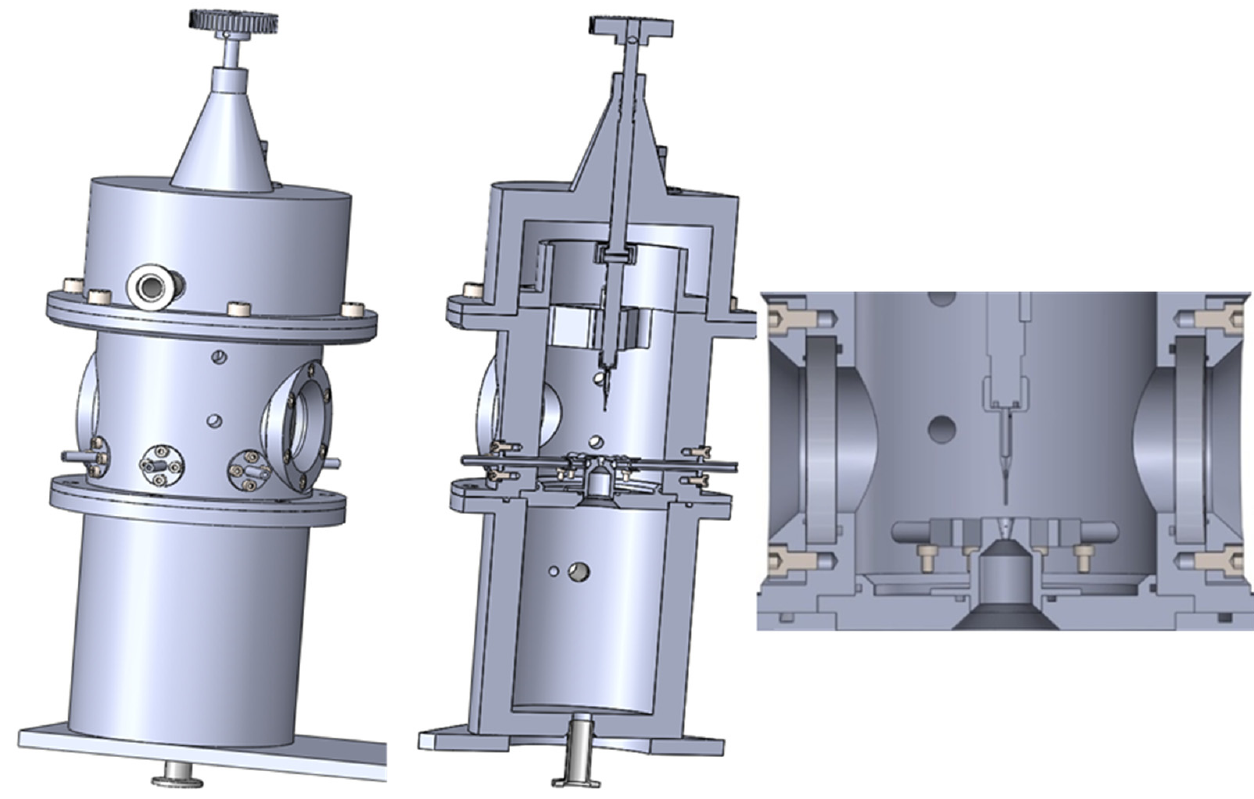
Figure 5. Experimental chamber [11].